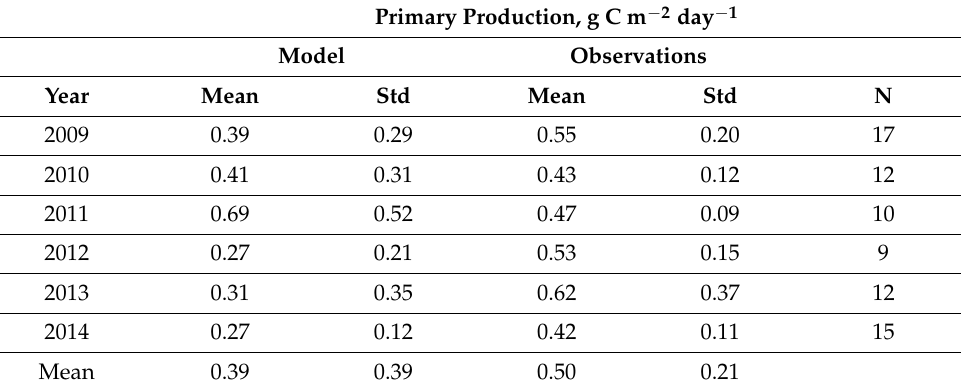
Table 3. Comparison of the simulated primary production (g C m − 2 day − 1 ) with estimates obtained using the bulk light–dark oxygen method at the end of July until the beginning of August in the Eastern Gulf of Finland (positions of the stations with measurements are indicated in Figure